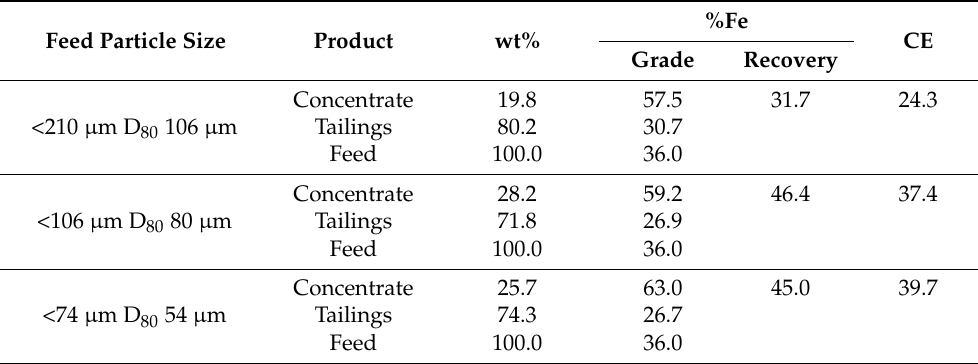
Table 1. Effect of the mesh of the grind on